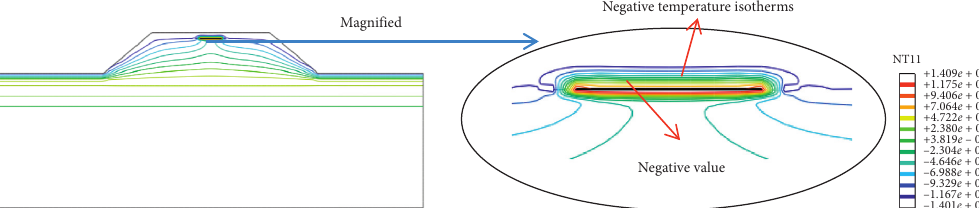
Figure 14: Temperature field distribution characteristics of the polymer grouting material when the central temperature decreased to 14 ° C.